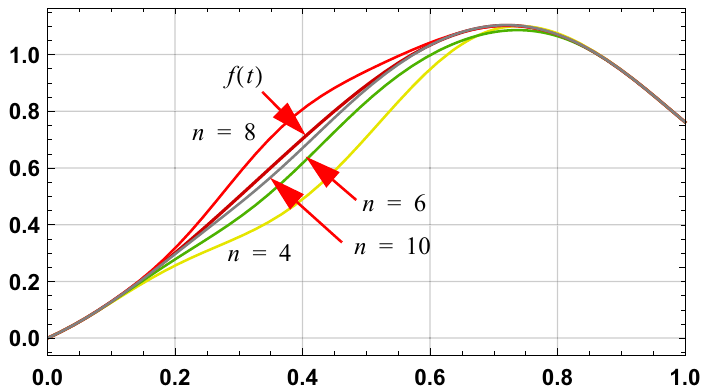
Figure 4. Graph of the 4th, 6th, 8th and 10th order dual Taylor series approximations, based on the interval [0, 1], for the function defined by